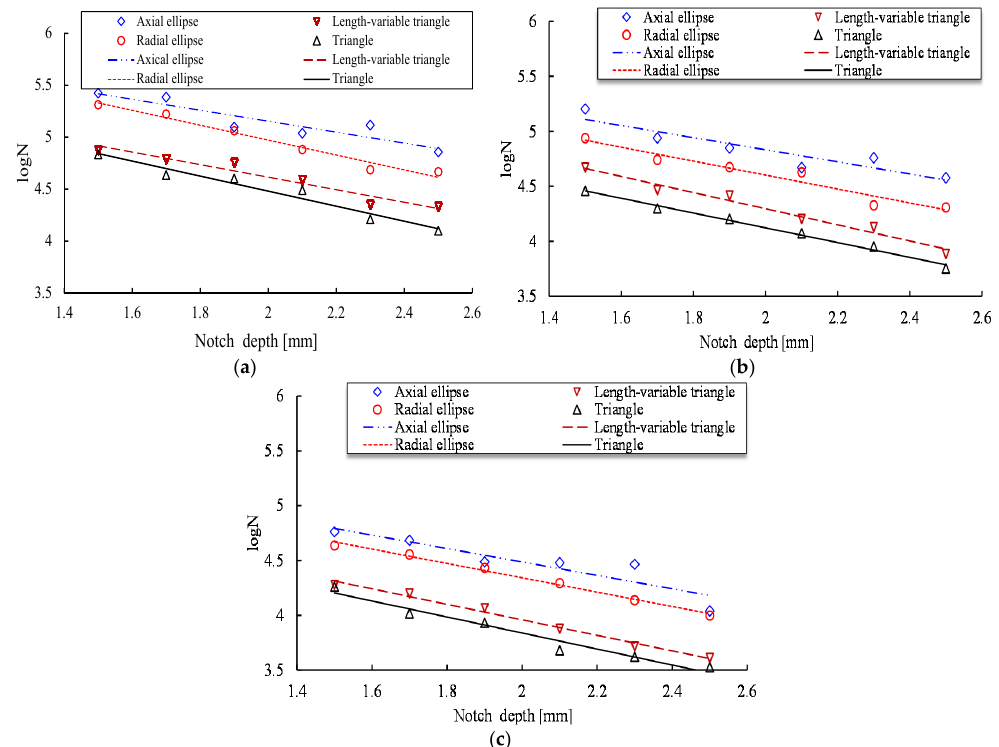
Figure 8. Fatigue life of steel bars under different maximum stress levels. ( a ) 0.4 R m ; ( b ) 0.5 R m ; ( c ) 0.6 R m .